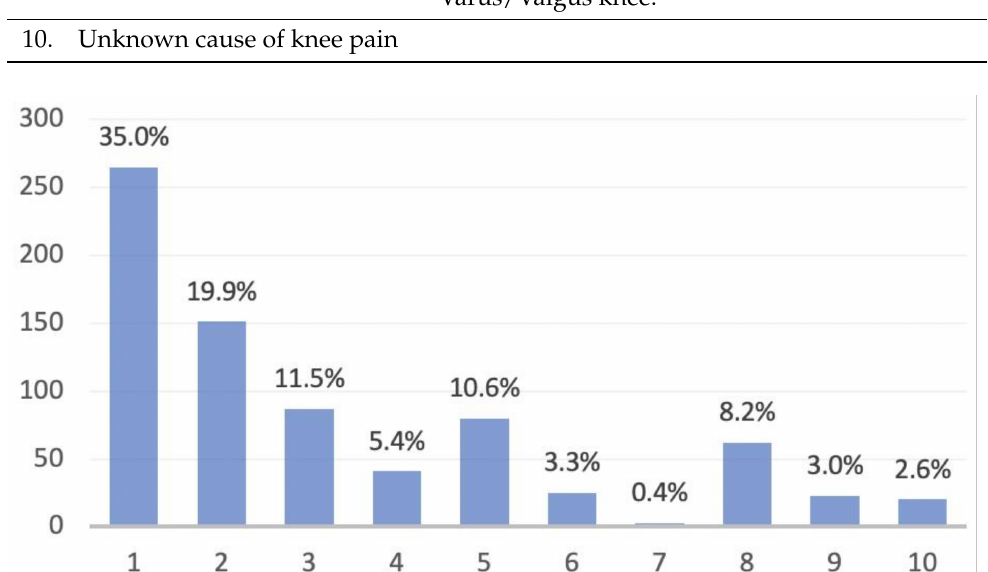
Figure 1. Distribution of the ten groups of diagnoses in 2019 knee medical records. (1) Post- surgery follow-up. (2) Degenerative disease. (3) Meniscus pathology. (4) Ligamentous pathology. (5) Patellofemoral disorders. (6) Osteocartilage pathology. (7) Growth pathology. (8) Traumatic injuries. (9) Other causes. (10) Unknown